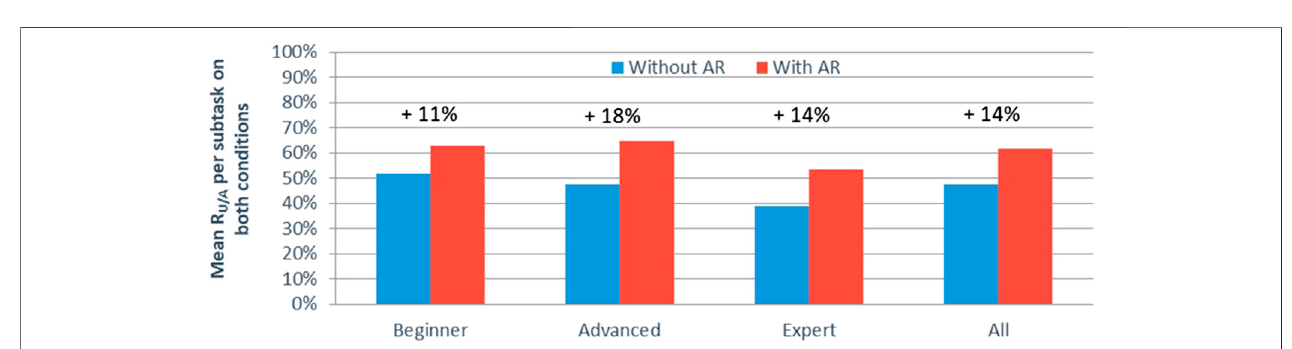
FIGURE 10 | Mean R UA value per sub-tasks for all pro fi les of users in both conditions.